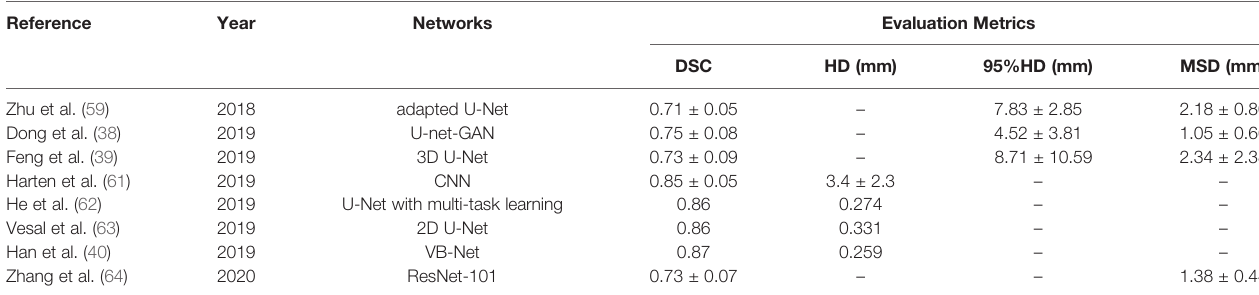
TABLE 3 | Comparison of selected works on segmentation of esophagus.